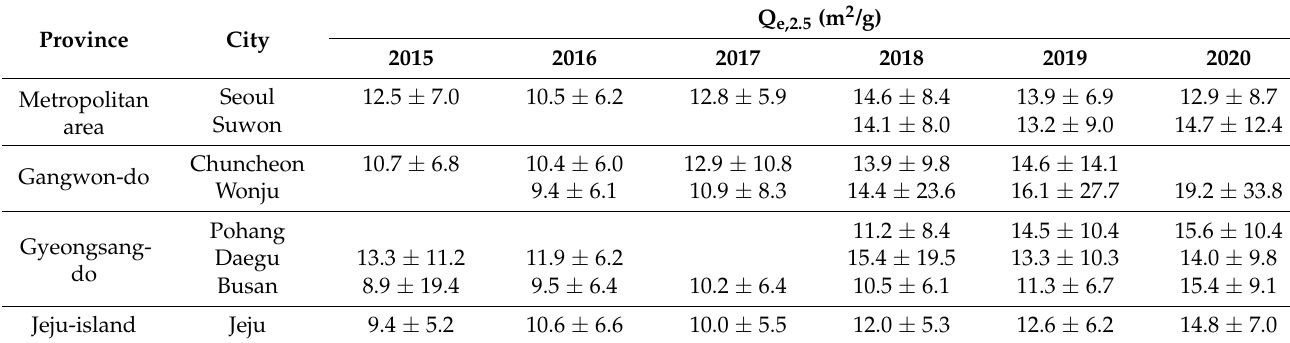
Table 6. Q e,2.5 by city from 2015 to 2020.